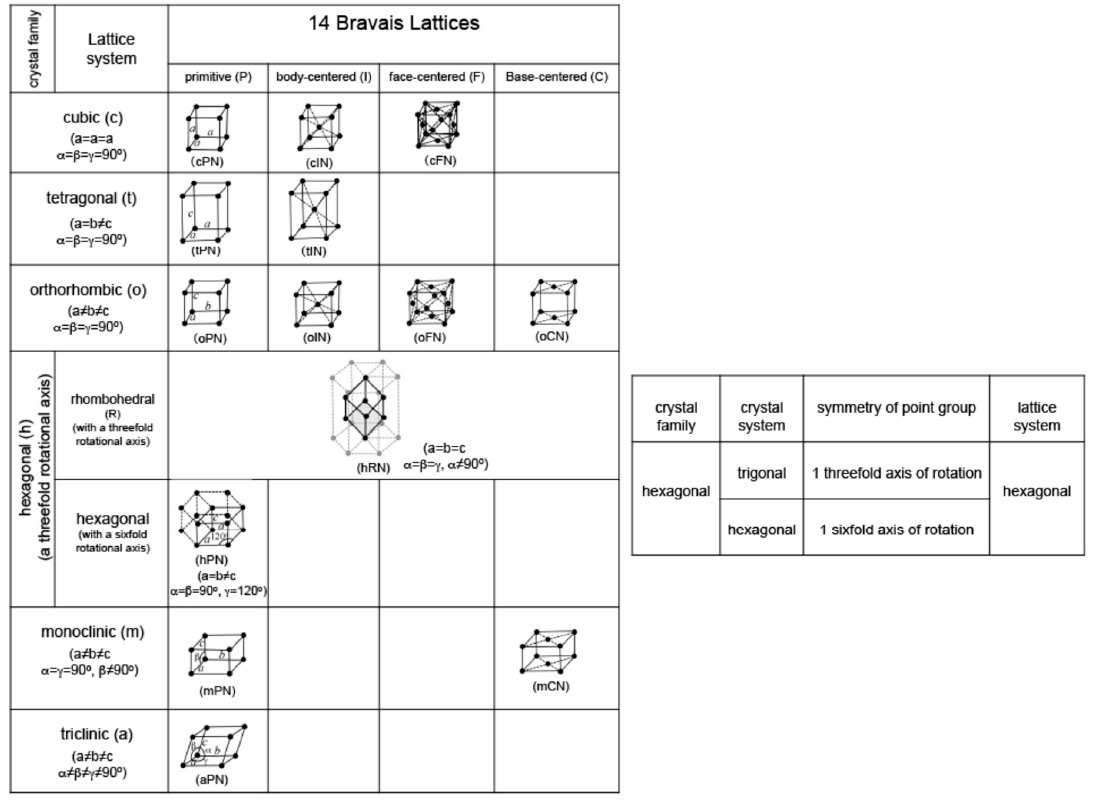
Figure 6. Seven lattices systems and fourteen Bravais lattices. The Pearson symbol is added in brackets. The right-hand panel shows that hexagonal in the crystal family can be also classified into trigonal and hexagonal with respect to the crystal system.